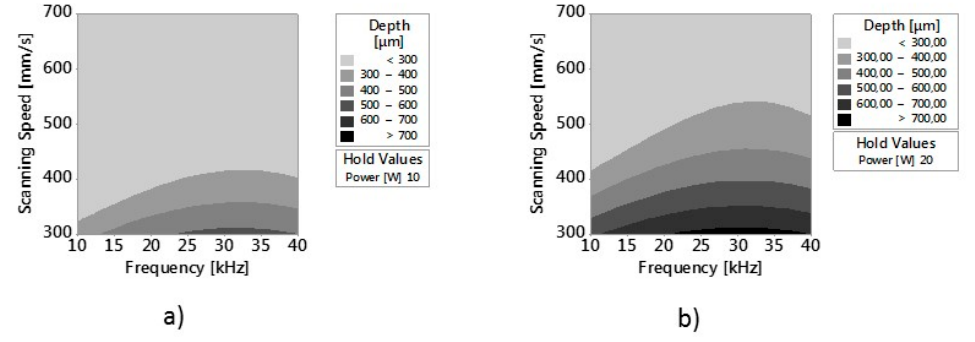
Figure 10. ( a ) Contour Plot of Depth versus v and F p at constant P of respectively 10 W and ( b ) 20 W. The contour Plots of (ER%) α for the two different P values confirm that values of (ER%) α lower than 25% can be obtained for P = 20 W, F p between 10 kHz and 35 kHz and v equal or slightly higher than 300 mm/min.